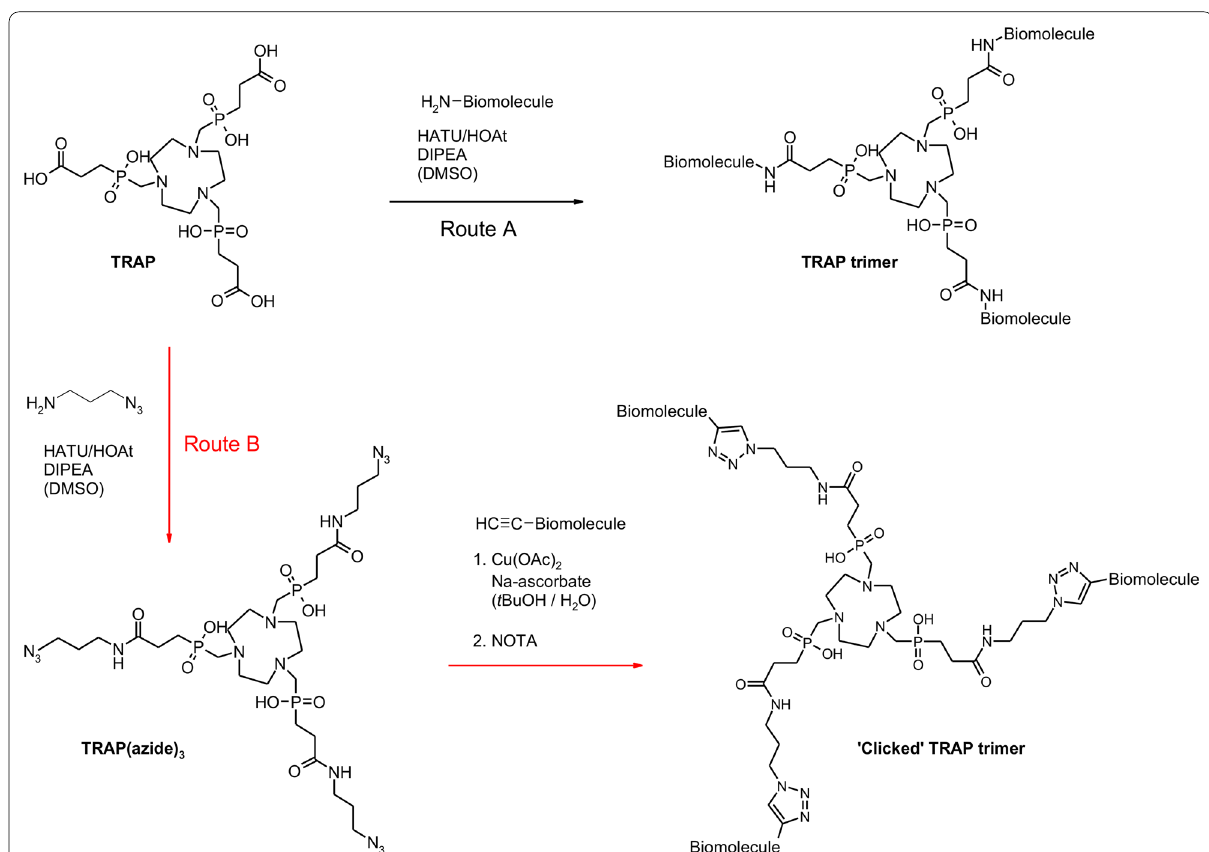
Fig. 6 Synthesis of trimeric TRAP bioconjugates. The preferred route B for elaboration of trimeric integrin ligands by means of ’click chemistry’ (CuAAC) is indicated by red arrows [91]. Of note, the CuAAC coupling was occasionally conducted with azide-decorated integrin ligands and alkyne-functionalized TRAP (obtained by amide coupling of propargyl amine, H 2 N–CH 2 –C Fig.